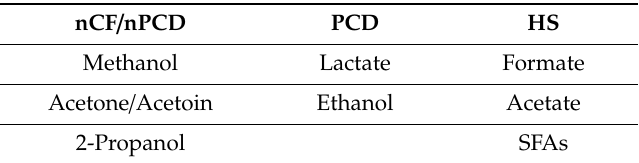
Table 3. Discriminating metabolites for the OPLS-DA model comparing data from healthy subjects, cases with nCF / nPCD and PCD bronchiectasis (see Figure 5 for details). Reported metabolites increase with respect to other classes a .